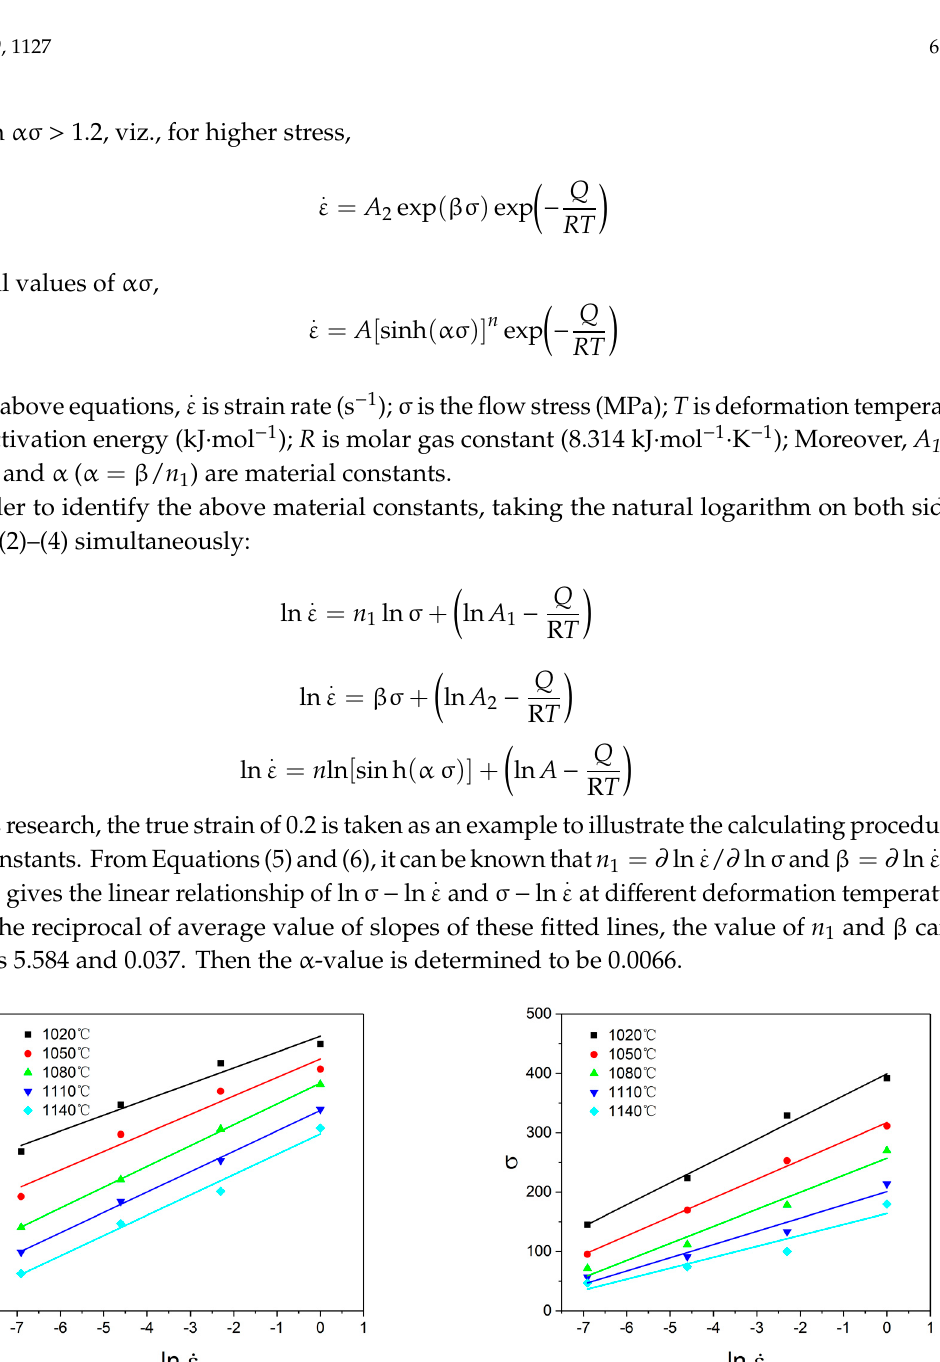
Figure 4. Relationship of the PM/Wrought dual superalloy between: ( a ) ln σ and ln ε ; ( b ) σ and ln ε .